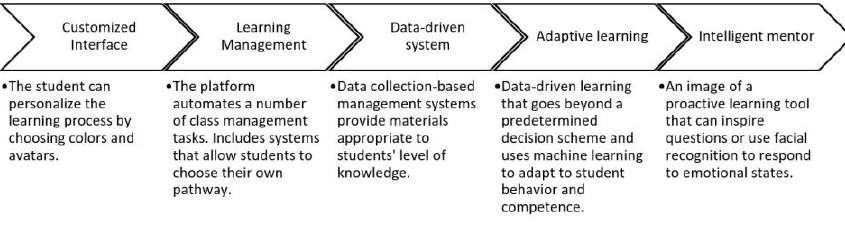
Fig. 2. Types of personalized learning systems with technological